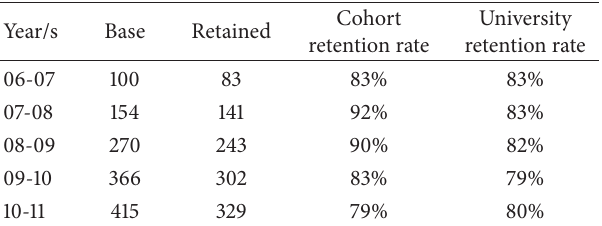
Table 2: Academic retention rates for the study cohort as compared to the wider student body.